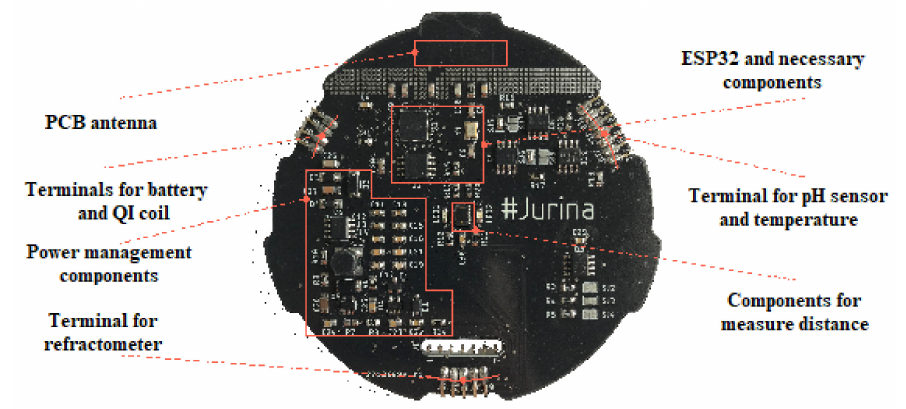
Figure 3. PCB used in the probe.